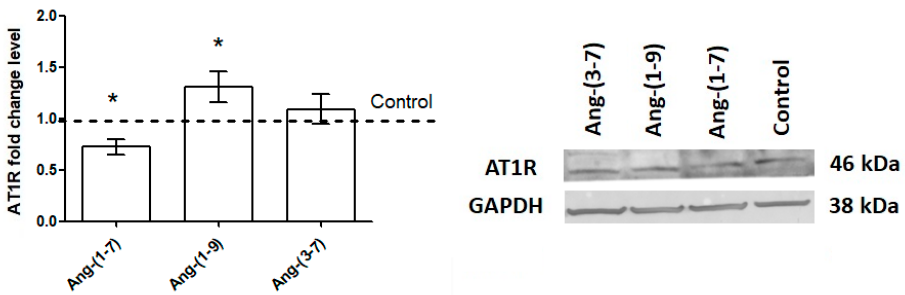
Figure 6. Western blot showing AT1R protein expression after incubation (48 h) of OVPA8 cells with tested angiotensins in the medium without FBS (mean ± SEM; one-way ANOVA with Tukey’s test: * p < 0.05).